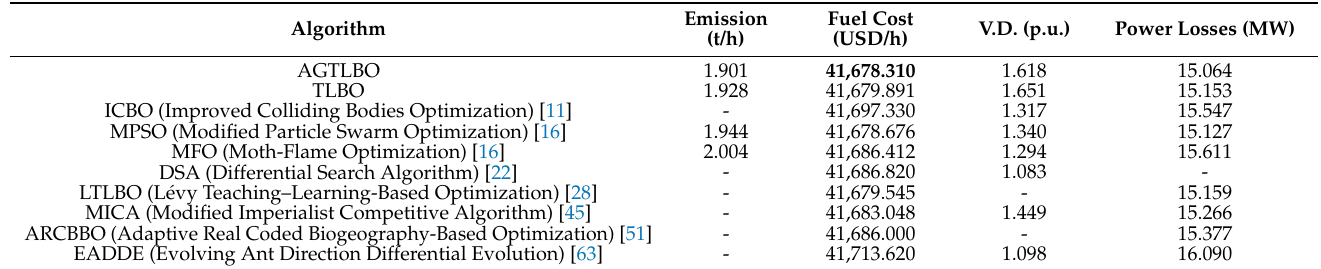
Table 11. Optimal results by different algorithms for Case 9.